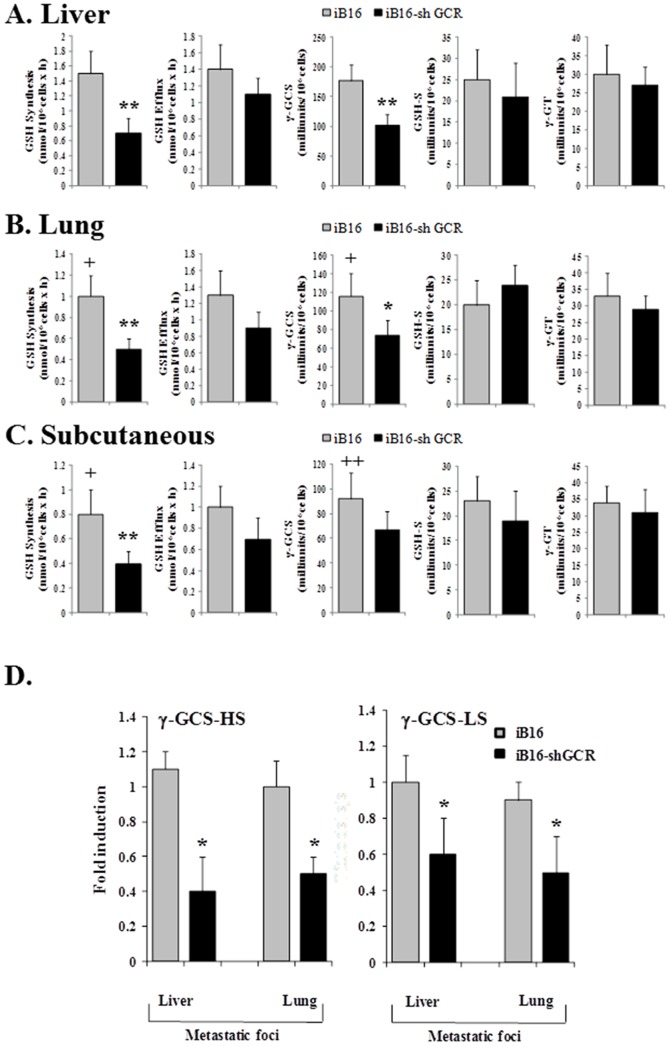
of glucocorticoid receptor knockdown on the rates of GSH synthesis and efflux in iB16 melanoma cells.(A–C) Melanoma cells were isolated from the liver or lungs 7 days after inoculation and from subcutaneous tumors 14 days after inoculation for culture. Glutathione efflux corresponded to GSH because GSSG was, in all conditions, 1–2% of the total glutathione found in the extracellular space (not shown). To prevent degradation of the GSH accumulated in the extracellular space, γ-GT was blocked by adding 10 µM acivicin to the culture medium 2 h before measuring efflux. Enzyme activities were measured 22 h after seeding. Results obtained in iB16 cells transfected with lentiviral vector not harboring any gene (negative control) were not different from control values (not shown). Data are mean values ± S.D. (n = 9–10 in all cases). *p<0.05,**p<0.01versus iB16 controls. +p<0.05, ++p<0.01 versus melanoma cells isolated from liver metastases. (D) γ-GCS-HS and γ-GCS-LS expression was determined in cells cultured for 24h (previously isolated from in vivo tumors). Data, expressed as a fold change, show mean values ± S.D. from 5 to 6 different experiments. *p<0.01 versus iB16 cells.